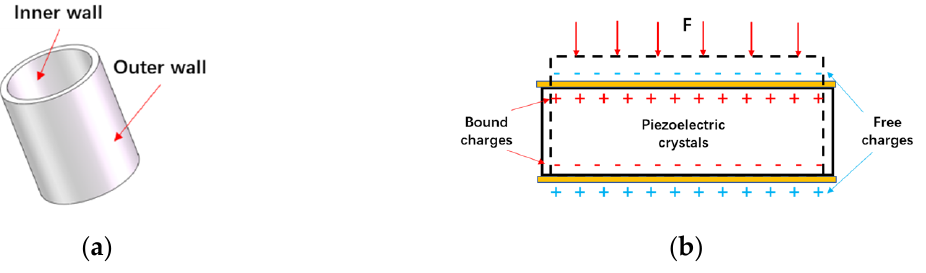
Figure 2. ( a ) Sensitive structure of sound pressure channel; ( b ) principle diagram of piezoelectric effect. Table 1. Parameters of sensitive